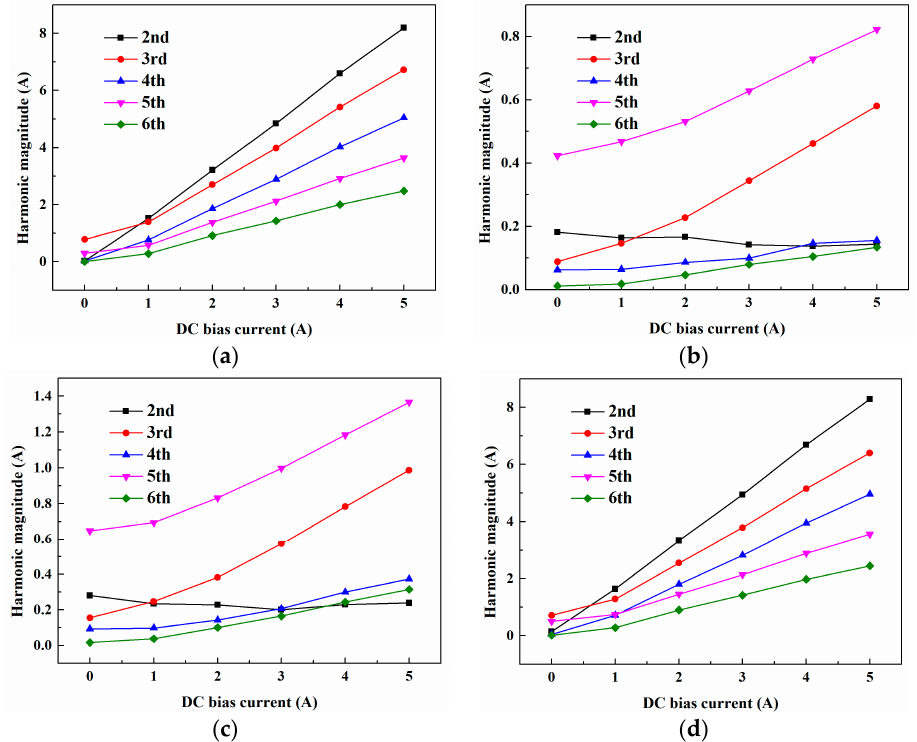
Figure 10. Magnitudes of harmonics of each winding current under various DC bias current. ( a ) series winding current. ( b ) common winding current. ( c ) low voltage winding current. ( d ) excitation current. Table 4. Performed test with RSM.